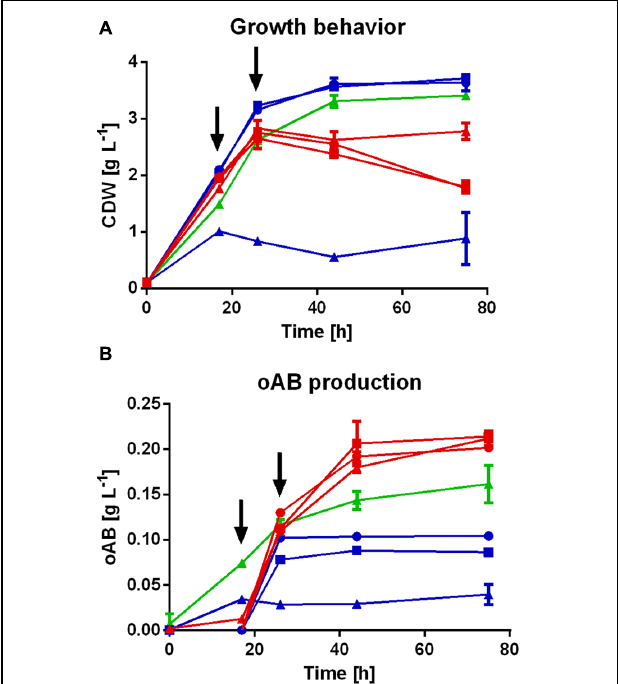
FIGURE 2 | oAB production profiles of various P. putida KT2440 strains in shake flasks. Biomass growth (A) and oAB production (B) of the following Pseudomonas putida KT2440 strains in an initial screening experiment: • , (cid:2) trpDC pSEVA234_ aroG D146N ; (cid:2) , (cid:2) trpDC pSEVA234_ trpE S40F G ; (cid:2) , (cid:2) trpDC pSEVA234_ aroG D146N _trpE S40F G ; (cid:2) , (cid:2) trpDC (cid:2) pheA • , (cid:2) trpDC (cid:2) pheA pSEVA234_ aroG D146N ; pSEVA234_ trpE S40F G ; (cid:2) , (cid:2) trpDC (cid:2) pheA pSEVA234_ aroG D146N _trpE S40F G ; (cid:2) , pSEVA234_ aroG D146N _trpE S40F G . All cultures were performed in mineral medium with 20 mM initial glucose concentration and addition of tryptophan